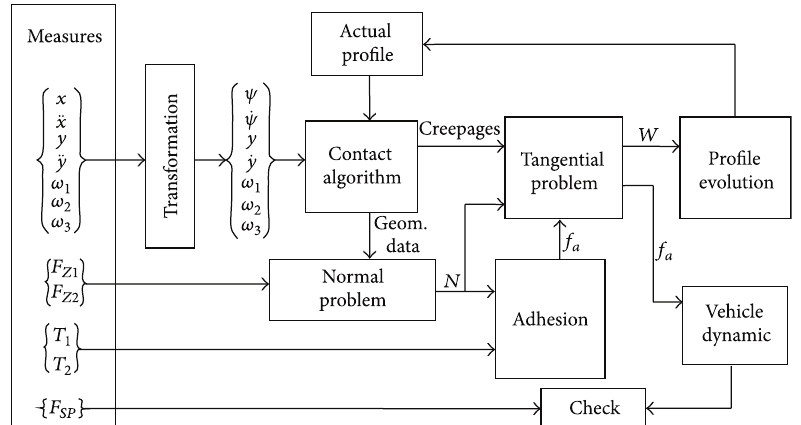
Figure 3: Scheme of the tasks performed by the control/acquisition